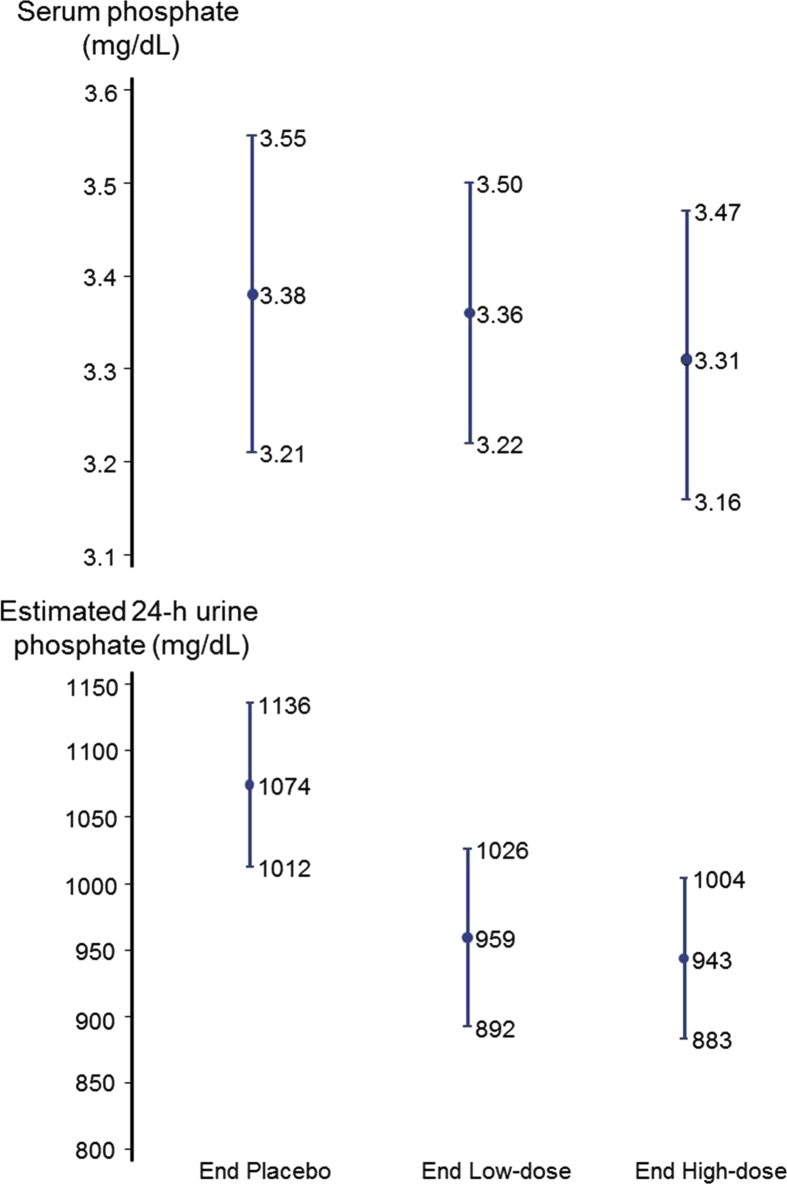
Mean of within-person serum phosphate and estimated 24-h urine phosphate levels (95% CIs) at the end of the placebo period, end of the low-dose (0.8 g per meal) sevelamer period, and end of the high-dose (2.4 g per meal) sevelamer period. P values were not significant for serum phosphate for either low-dose or high-dose sevelamer versus placebo and P < 0.001 for urine phosphate for both low-dose and high-dose sevelamer versus placebo.